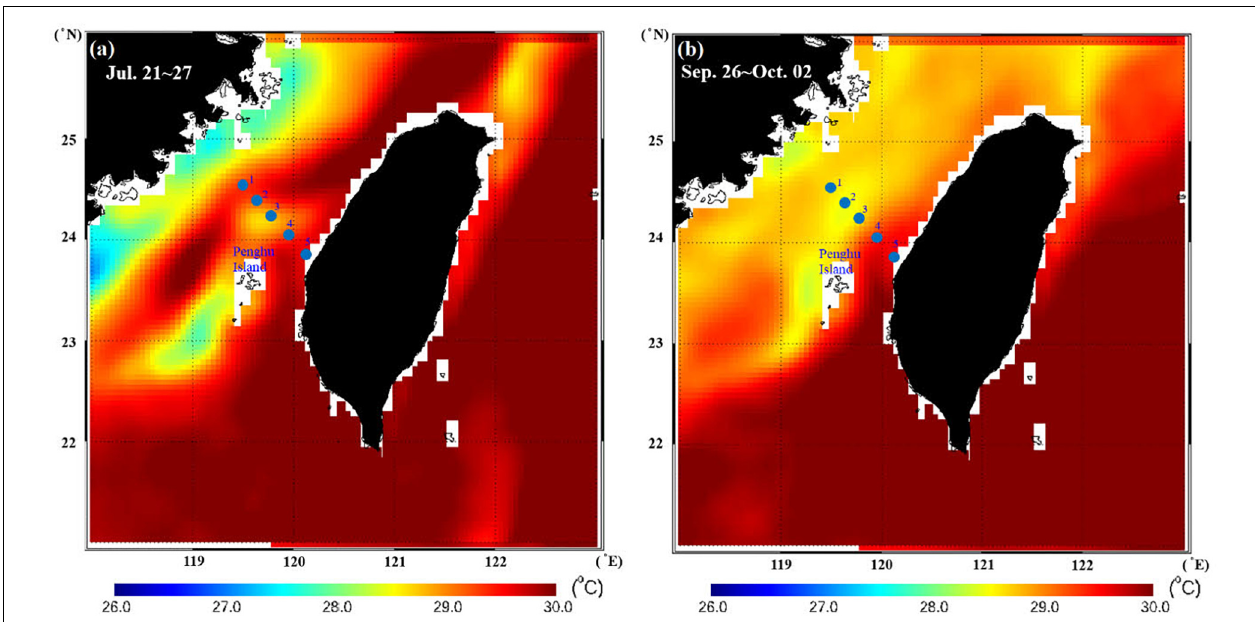
FIGURE 8 | The weekly composite images of satellite sea surface temperature (a) between July 21 and July 27, 2017 and (b) between September 26 and October 02, 2017. Data were from the group for high resolution sea surface temperature (GHRSST) project, NASA.